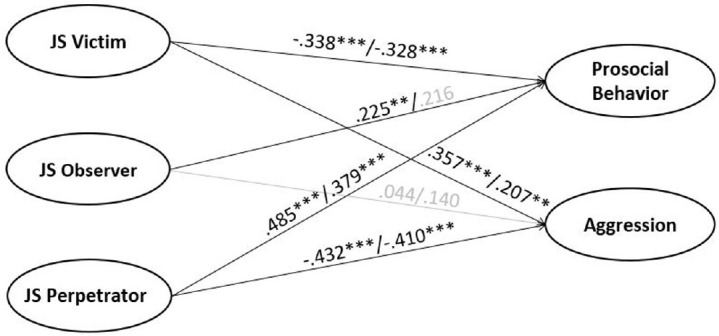
Predicting prosocial behavior and aggression from victim, observer, and perpetrator justice sensitivity (cross-sectional prediction/longitudinal prediction). Controlled for age and gender. Cross-sectional Model: χ2(34, N = 846) = 119.199, p < 0.001, RMSEA = 0.054, CFI = 0.975, SRMR = 0.025; Longitudinal Model: χ2(34, N = 932) = 86.345, p < 0.001, RMSEA = 0.041, CFI = 0.983, SRMR = 0.025.